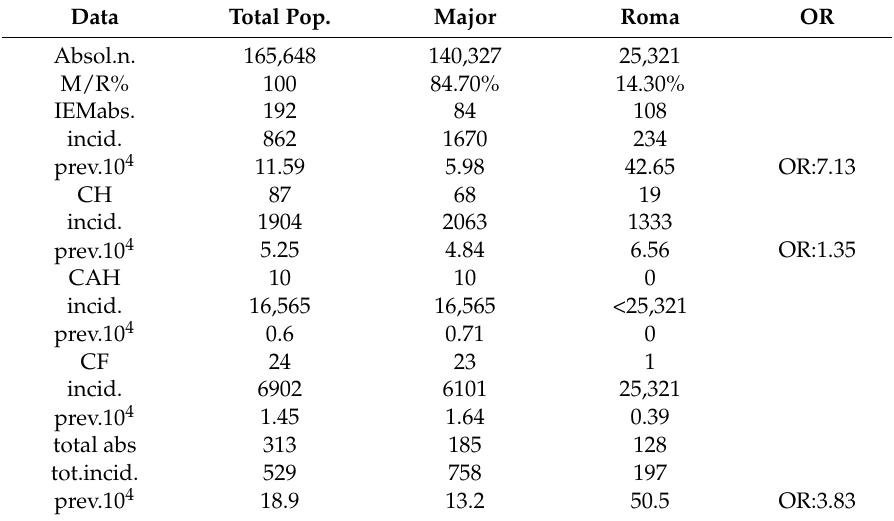
Table 2. Results of extended newborn screening in Slovakia 2013–2015.